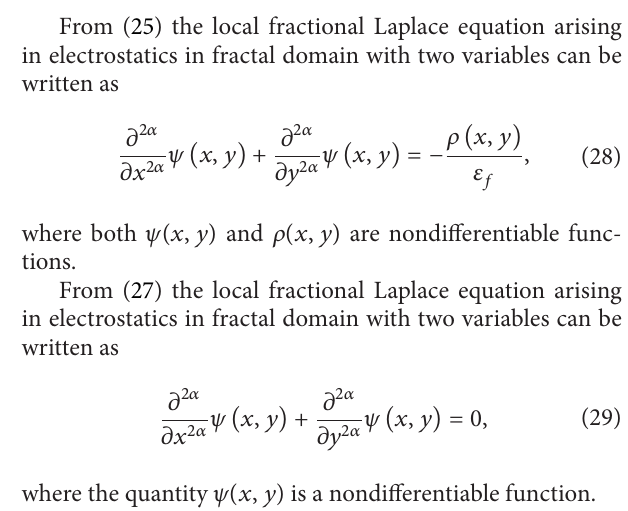
From (25) the local fractional Laplace equation arising in electrostatics in fractal domain with two variables can be written as